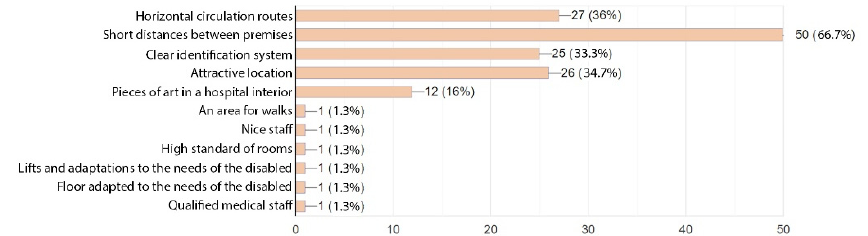
Figure 13. Spatial expectations of Figure 13 . Spatial expectations of patients .